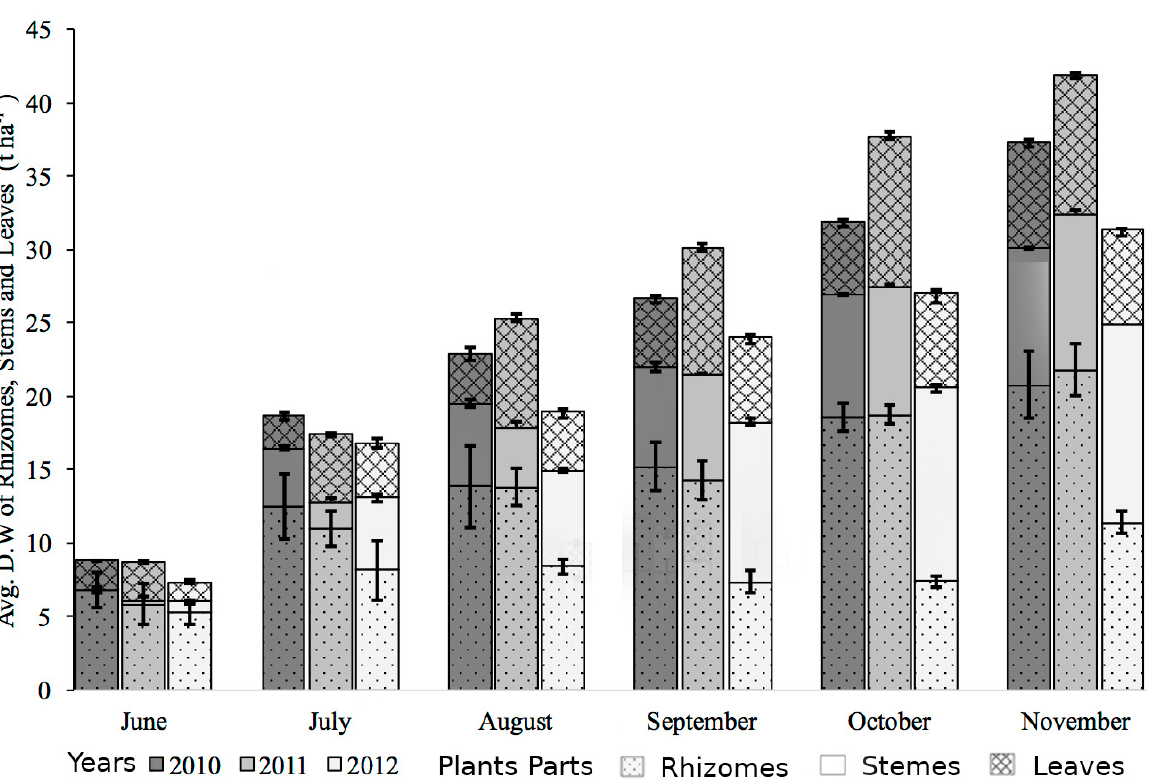
Figure 3. Dry weight yield across three years 2010–2012 (growth years 4 to 6) of M. × giganteus growing in the Lower Silesia Region of Poland. Legends indicate growth year; bar, standard error n = 4.